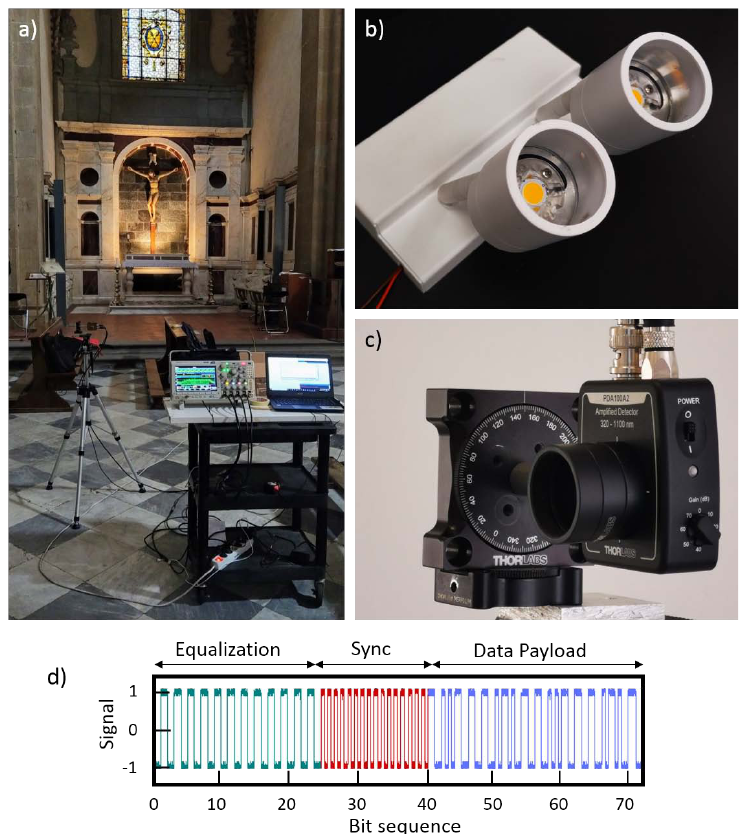
Figure 1. ( a ) Overview of VLC experimental setup used in the Basilica of Santa Maria Novella; ( b ) LED light sources used as TX stage and ( c ) custom RX stage, with shield tube for FoV adjustment visible. D represents the input tube diameter, L its length. ( d ) Data frame composition (NRZ-OOK with Manchester encoding) used in the experiments (see